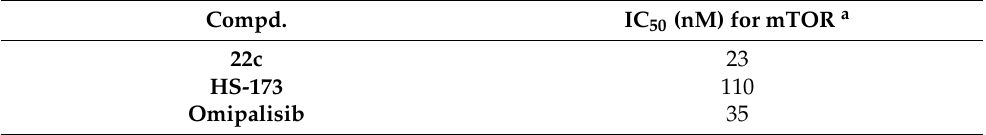
Table 4. Inhibition of 22c against